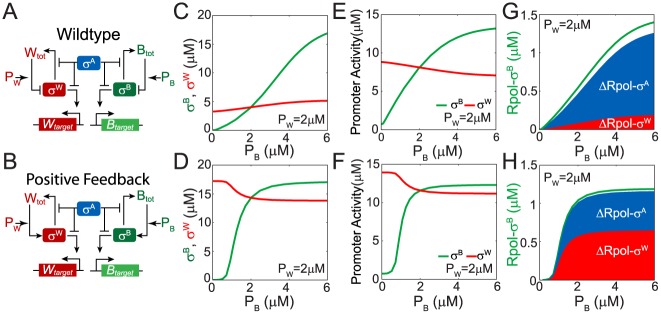
Negative feedback minimizes competition between stress σ factors for RNA polymerase.A,B. Simplified network diagrams of stress σ-factors σB and σW and housekeeping σ-factor σA competing with each other for RNA polymerase. σB and σW activities are regulated by negative and positive feedbacks in (A) and (B) respectively. In both cases, signaling proteins PB and PW control the stress-signal driven activation of σB and σW respectively. C, D. Dependence of free σB and σW levels on PB at fixed PW (= 2μM). In the wildtype negative feedback system (C), increase in σB phosphatase leads to an increase in both free σB (green curve) and free σW (red curve). In the positive feedback system (D), increase in σB phosphatase leads to an increase in free σB (green curve) and a decrease in free σW (red curve). E, F. σB and σW target promoter activities as a function of PB at fixed PW in the wildtype negative feedback system (E), and the positive feedback system (F). G, H. RNA polymerase bound σB (Rpol-σB) as a function of PB at fixed PW in the wildtype negative feedback system (G) and the positive feedback system (H). Increase in σB phosphatase (PB) leads to an increase in Rpol-σB (green curve) and corresponding decreases ΔRpol-σW (core complex with σW, red area) and ΔRpol-σA (complex with σA, blue area).